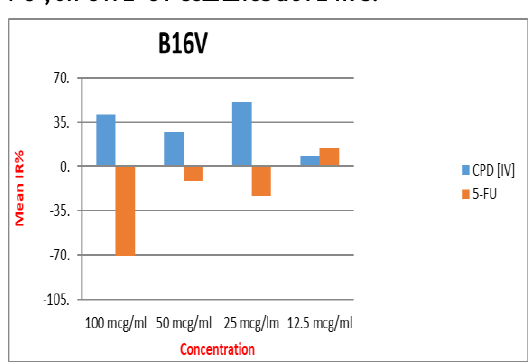
Figure 2. Inhibition rate% (%IR) versus different concentrations of compound [IV] and 5- FU, on B16V cell lines at 72 hrs. (Negative values indicate increased proliferation). Table 3. IC50 values in mcg/ml for 5-FU and